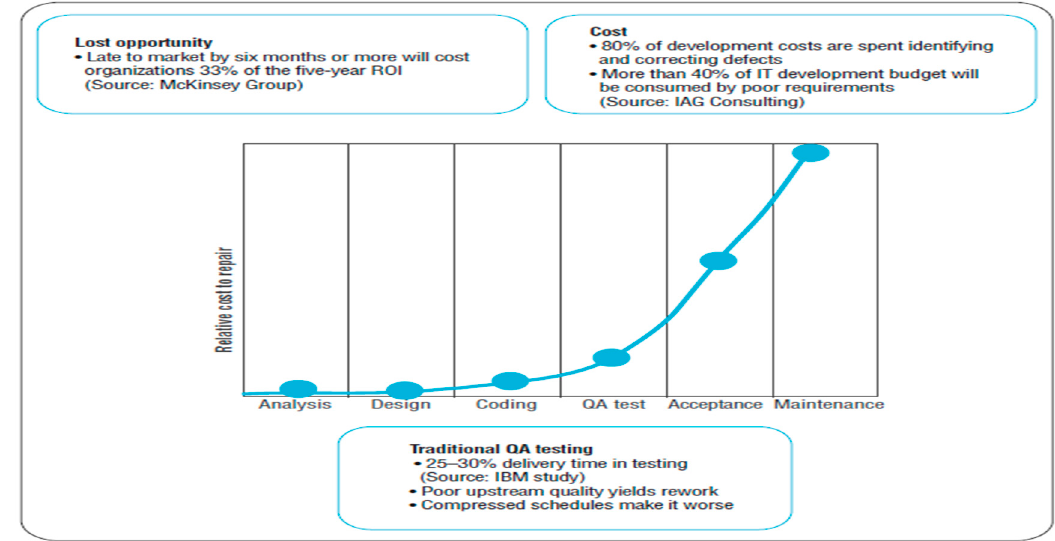
Figure 1. Opportunities to optimize quality and time to market exist throughout the application development lifecycle [6].